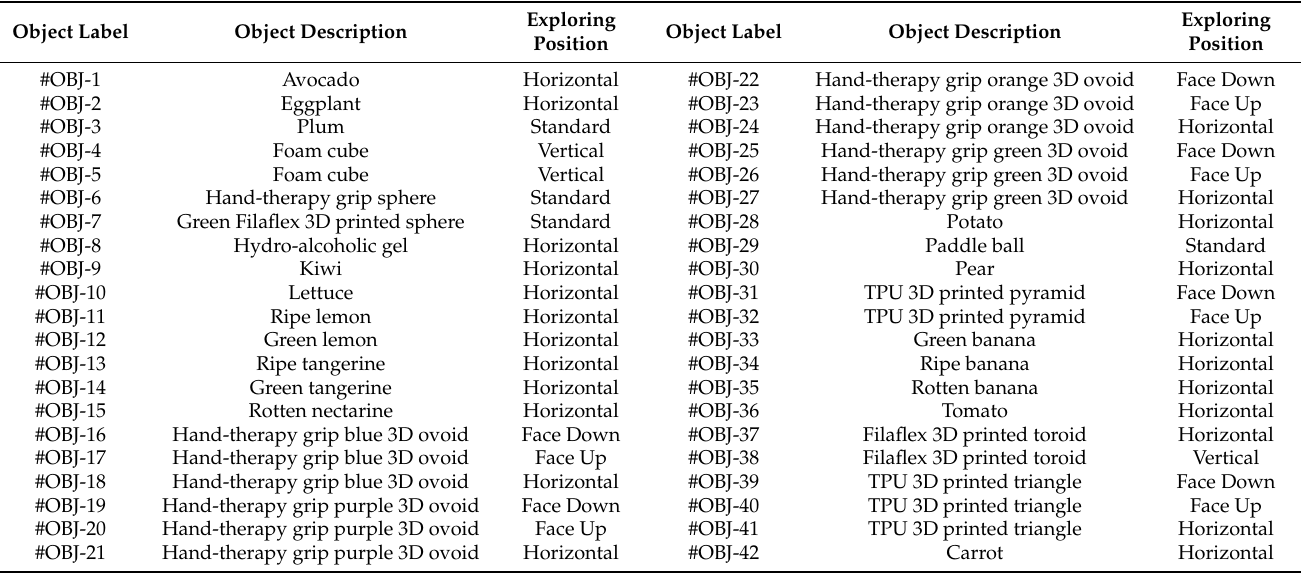
Figure 4. Set of 42 object classes used to carry out the palpation exploration, also see Table 1. Table 1. Table with the forty-two classes employed in this work, also see Figure